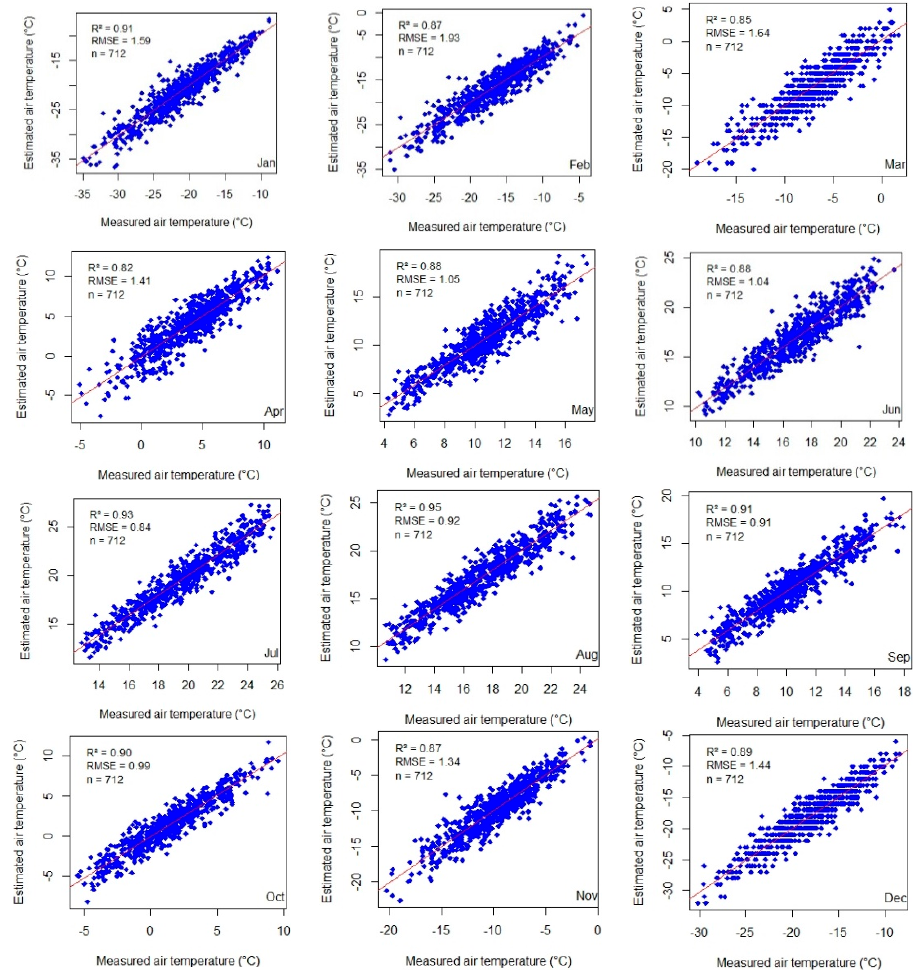
Figure 6. Comparison between measured and estimated monthly average Ta using LSTd, LSTn, and elevation for the RF regression model.